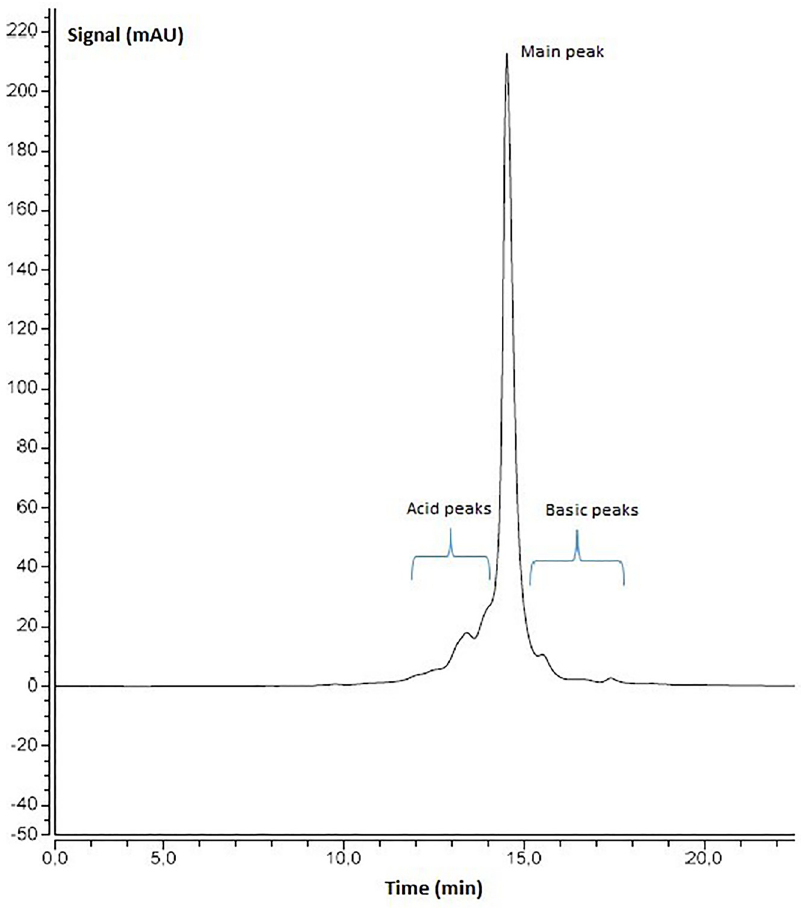
Figure 4: Cation exchange chromatography pro fi les of Bevacizumab. No di ff erence was observedintermsoftherelativepercentageof acidic and basic variants.